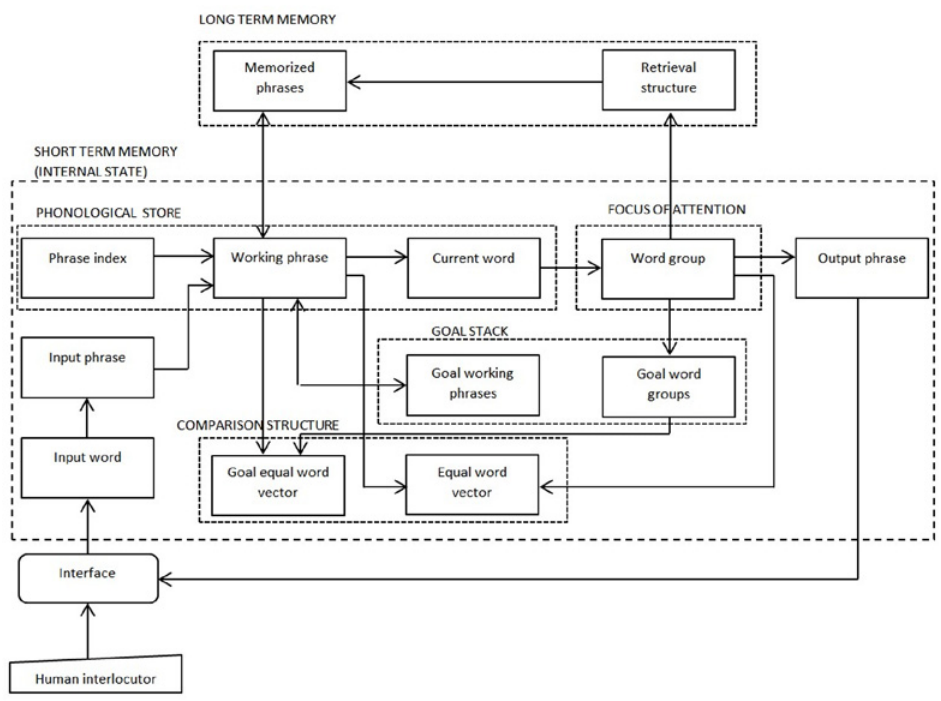
Fig 5. Schematic diagram of the main system architecture. Each rectangle represents a subnetwork, which is composed by interconnected artificial neurons. Only the main subnetworks are represented in this diagram. The arrows that join the rectangles represent directional connections among neurons of different